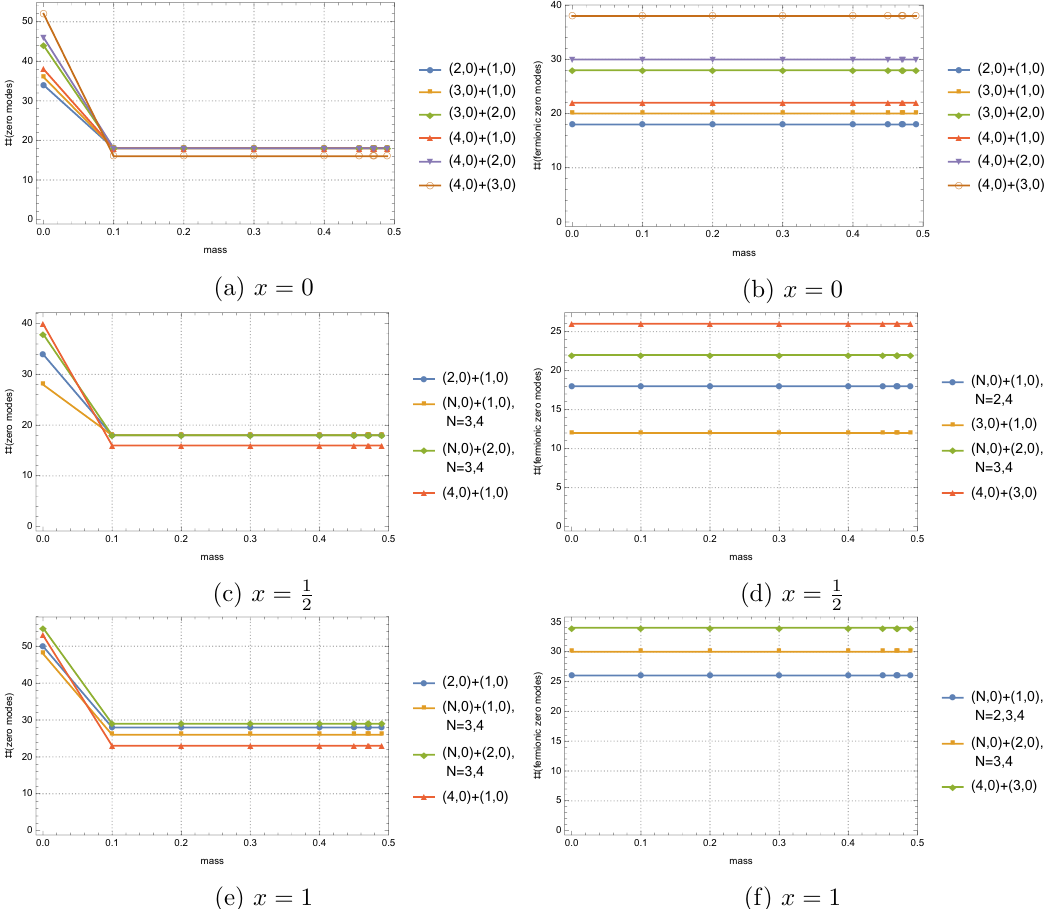
Figure 31. C [( N 1 ; 0)] + C [( N 2 ; 0)] + D with Higgs con(cid:12)guration (B.19). The number of bosonic zero modes is shown in (a), (c), and (e), while the number of zero modes of D X + (cid:30) are provided in (b), (d), and